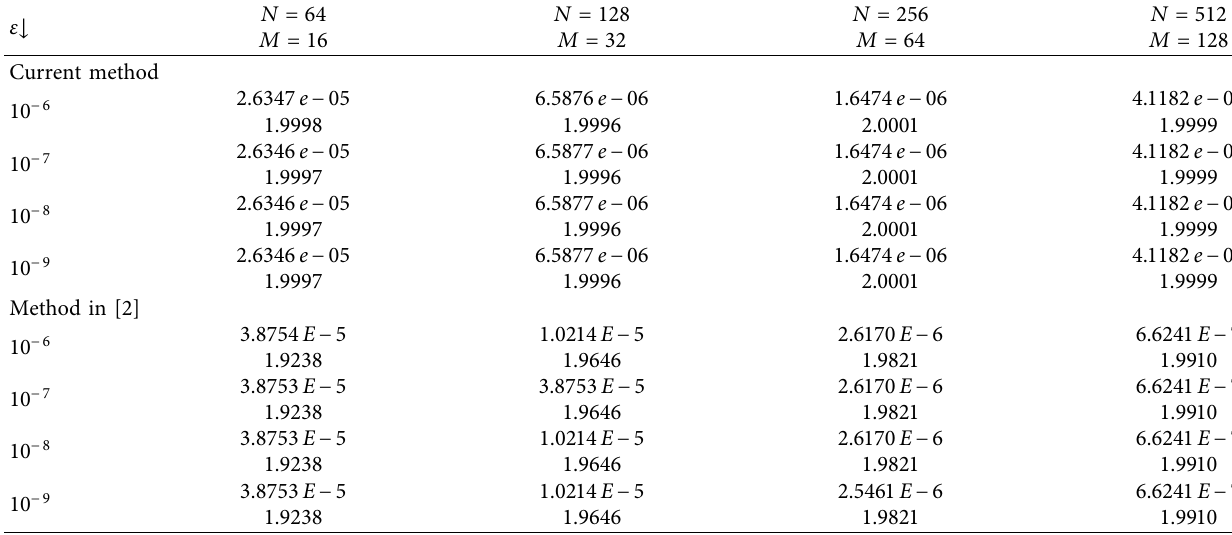
Table 3: Comparison of the maximum pointwise error and rate of convergence for Example 3 for μ � 10 − 7 and different values of ε . N � ε ↓